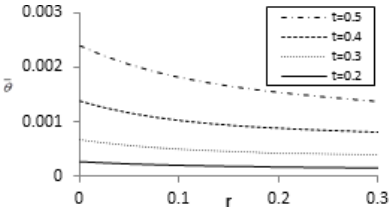
Figure 7: Distribution of temperature with the radius via RPL ℜ = 4